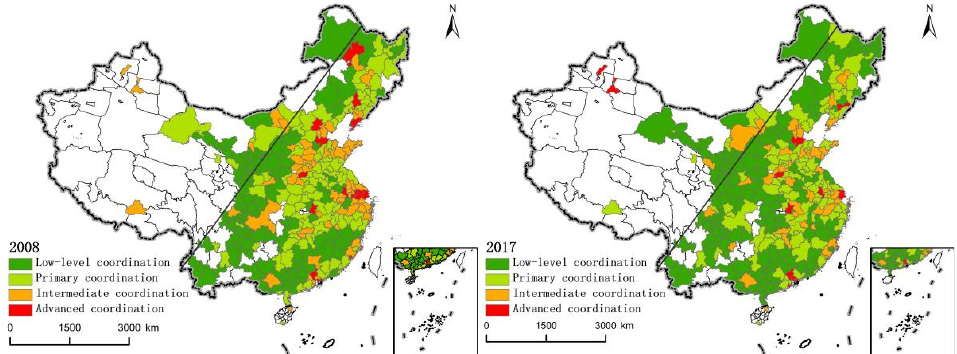
Figure 2. Distribution of “production-living-ecology” functional coordination in China from 2008 to 2017.